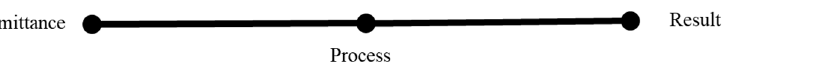
Figure 5. Playing field for evaluating the effectiveness of an element of the region’s economic secu- rity system: admittance–process–result.